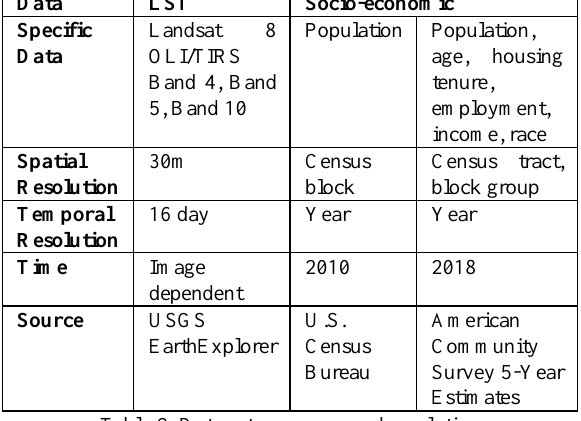
Table 2. Data sets, sources, and resolution